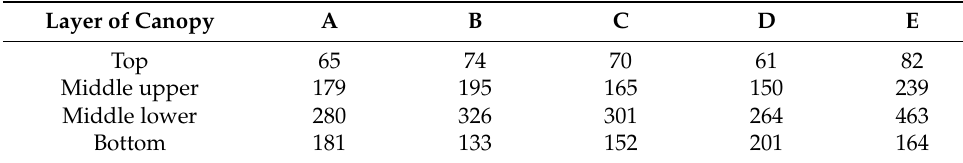
Table 4. The numbers of leaves in the different areas of the pear canopy. Layer of Canopy